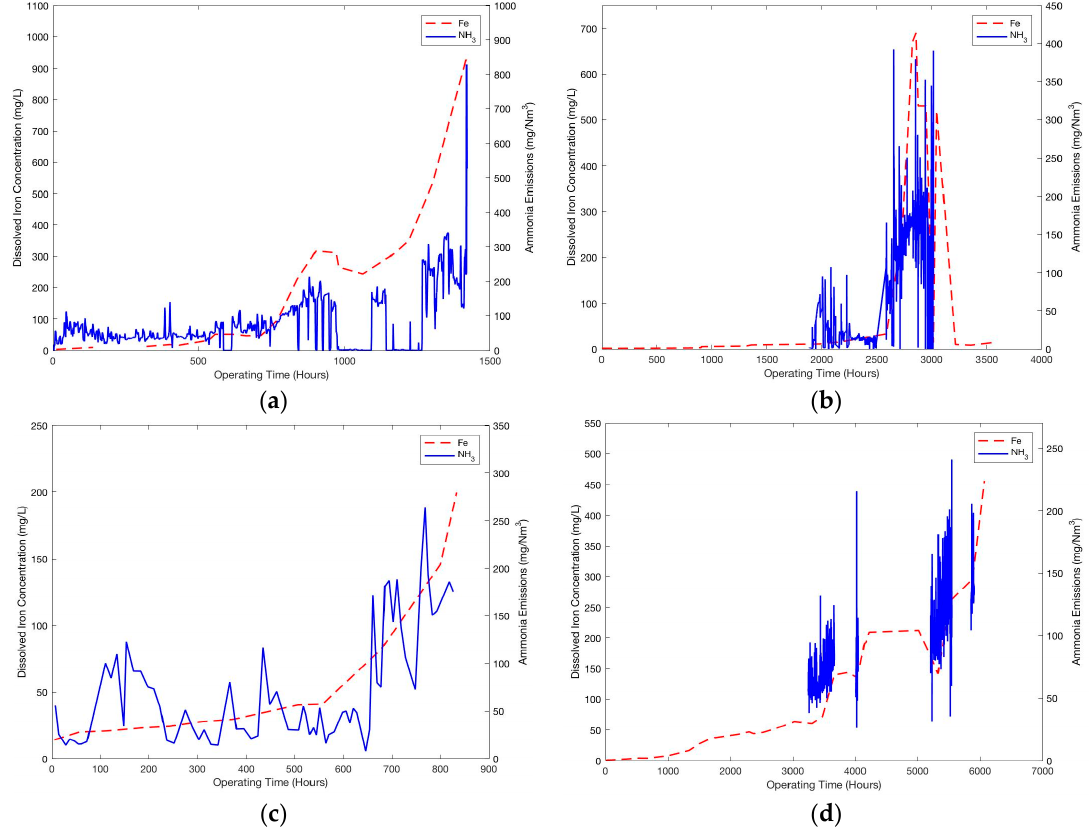
Figure 2. Dissolved iron concentration and ammonia emissions as measured at; ( a ) EnBW’s pilot campaign; ( b ) TNO’s pilot campaign; ( c ) CSIRO’s Loy Yang Campaign; and ( d ) Esbjerg pilot campaign [14].